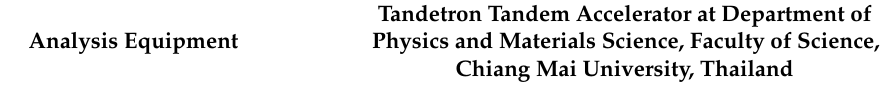
Table 2. Parameters for PIXE analysis used in this